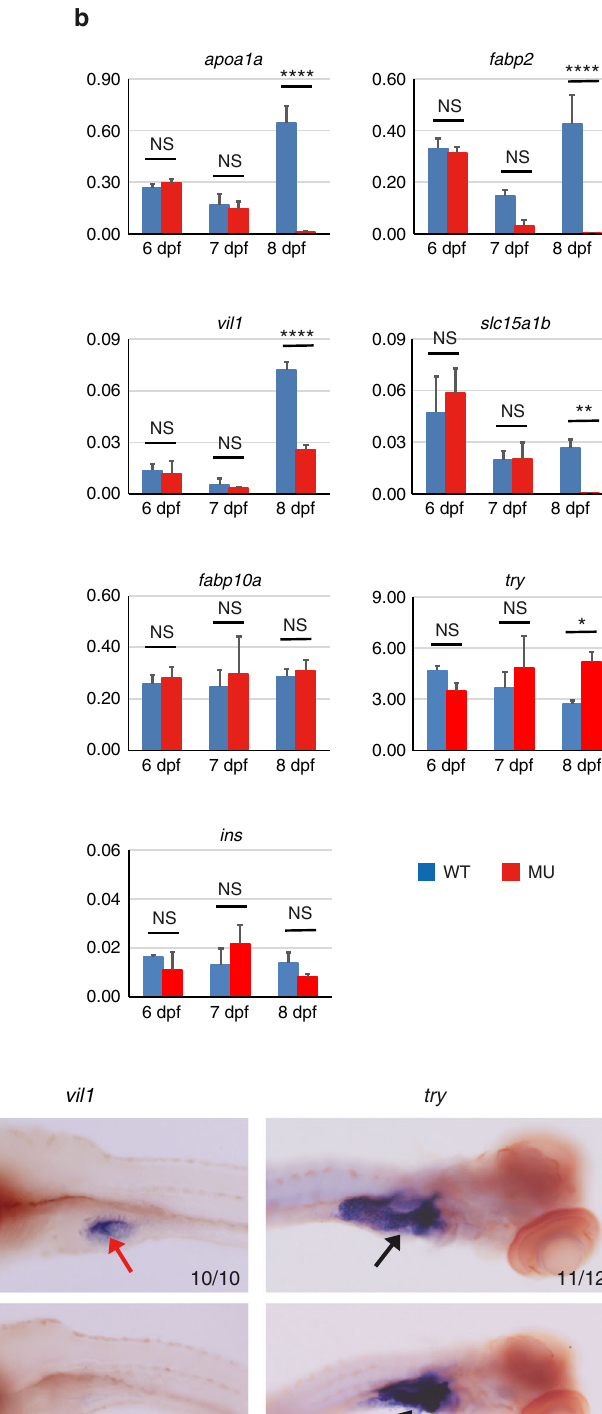
Numbers represent (embryos with the indicated phenotype)/(total embryos